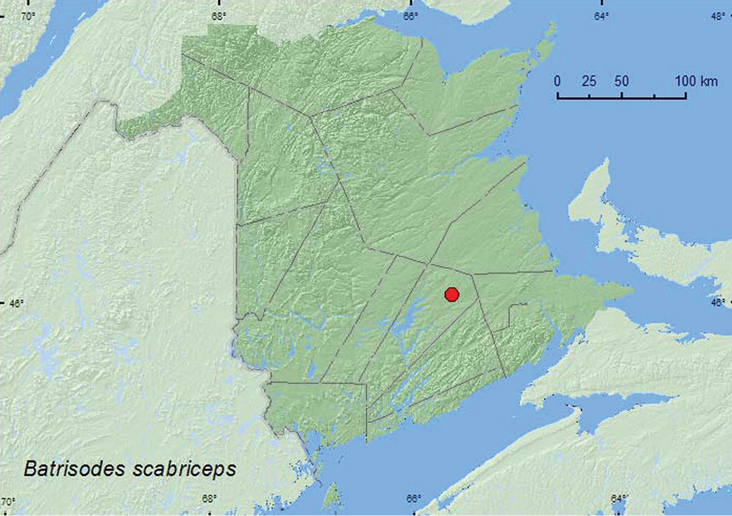
Collection localities in New Brunswick, Canada of Batrisodes scabriceps.